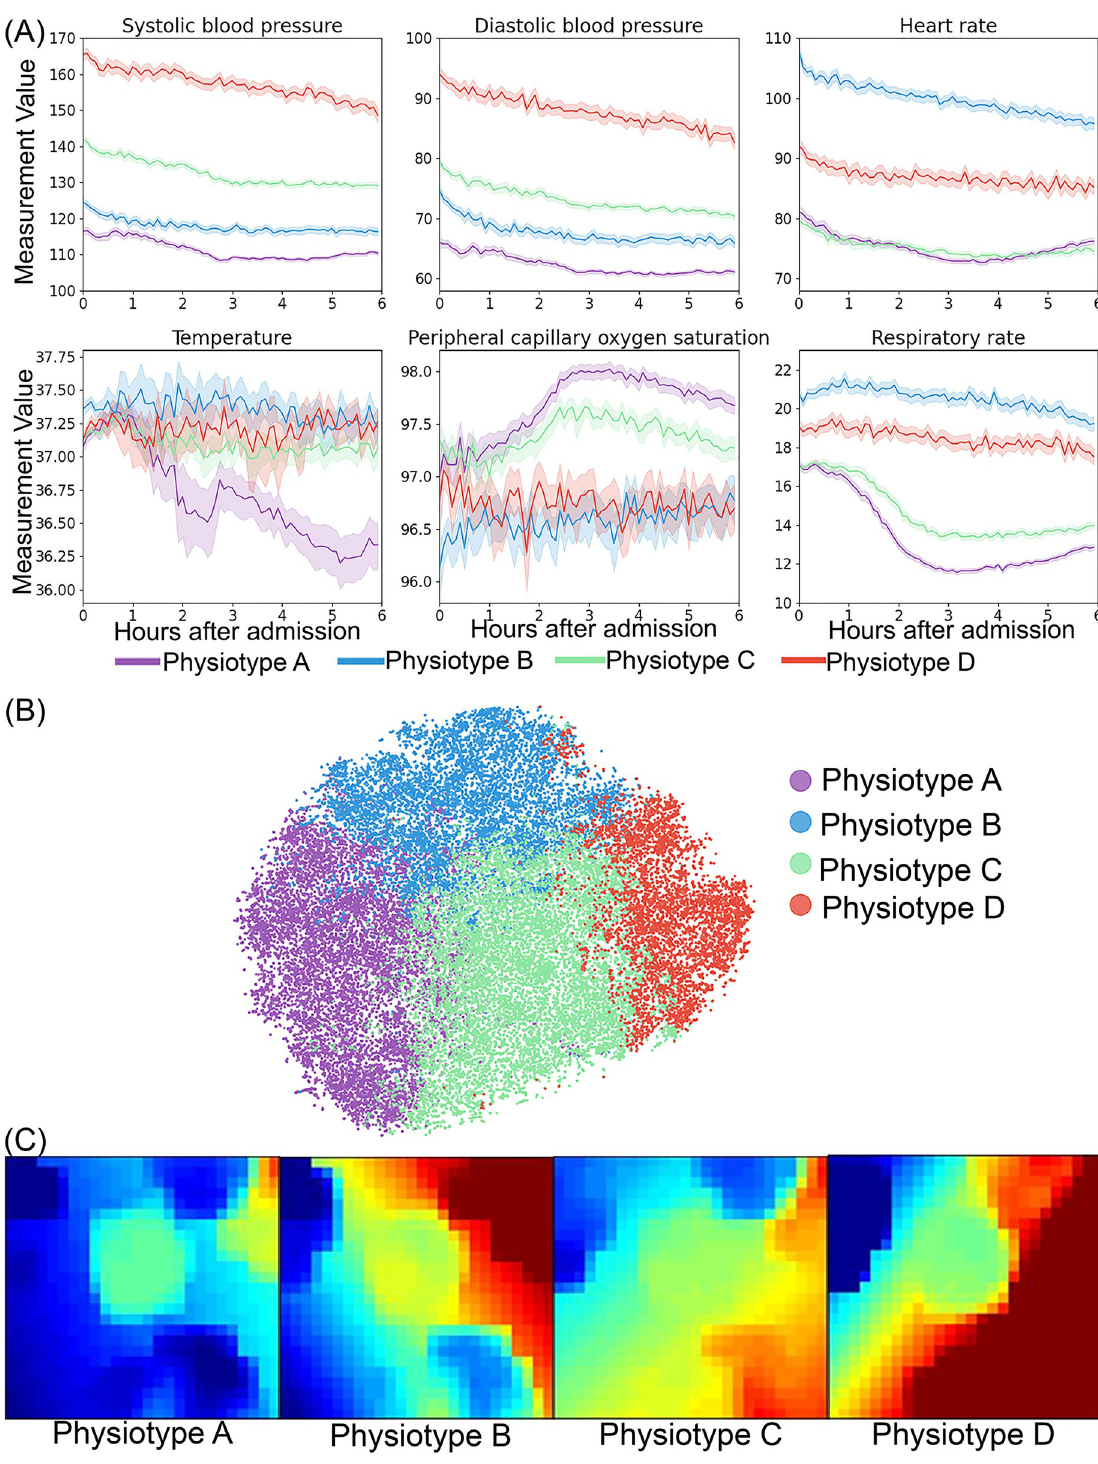
Fig 1. Physiotype vital sign representations. (A) Distribution of vital signs during the first six hours of hospital admission. (B) Visualization of physiotypes using the t-distributed stochastic neighbor embedding (t-SNE) technique. (C) Physiotype average vital sign mosaics using a self-organizing